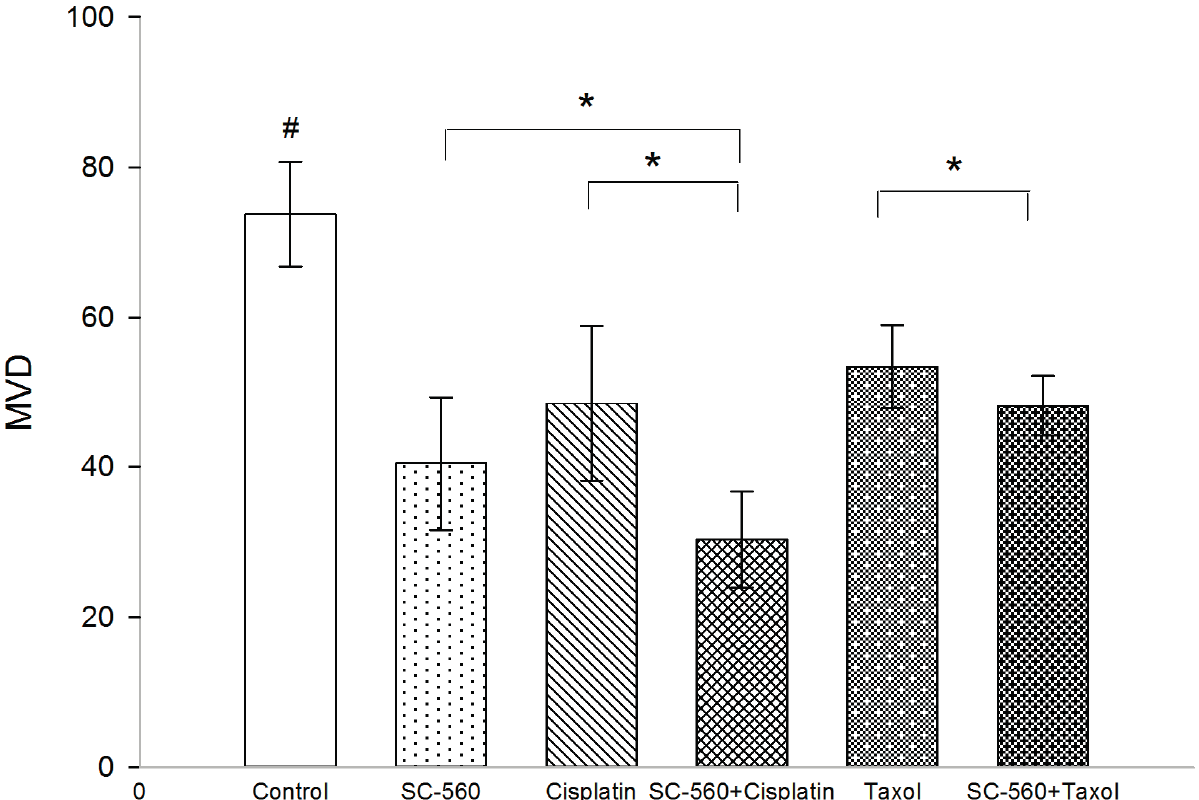
Figure 2. Effects of SC-560 combined with cisplatin or taxol on microvessel density (MVD) in vivo . MVD of control group compared with drug-treated groups illustrated the significantly inhibitory effect of SC-560 in combination with cisplatin or taxol on tumor. # MVD of treatment groups compared with control group, p < 0.05 for all; * p < 0.05; error bars indicate standard error.